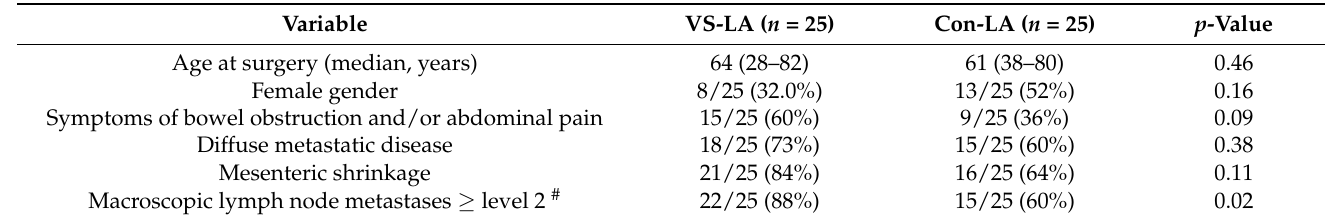
Table 1. Clinical characteristics and intraoperative findings in patients with SI-NENs undergoing small bowel resection.